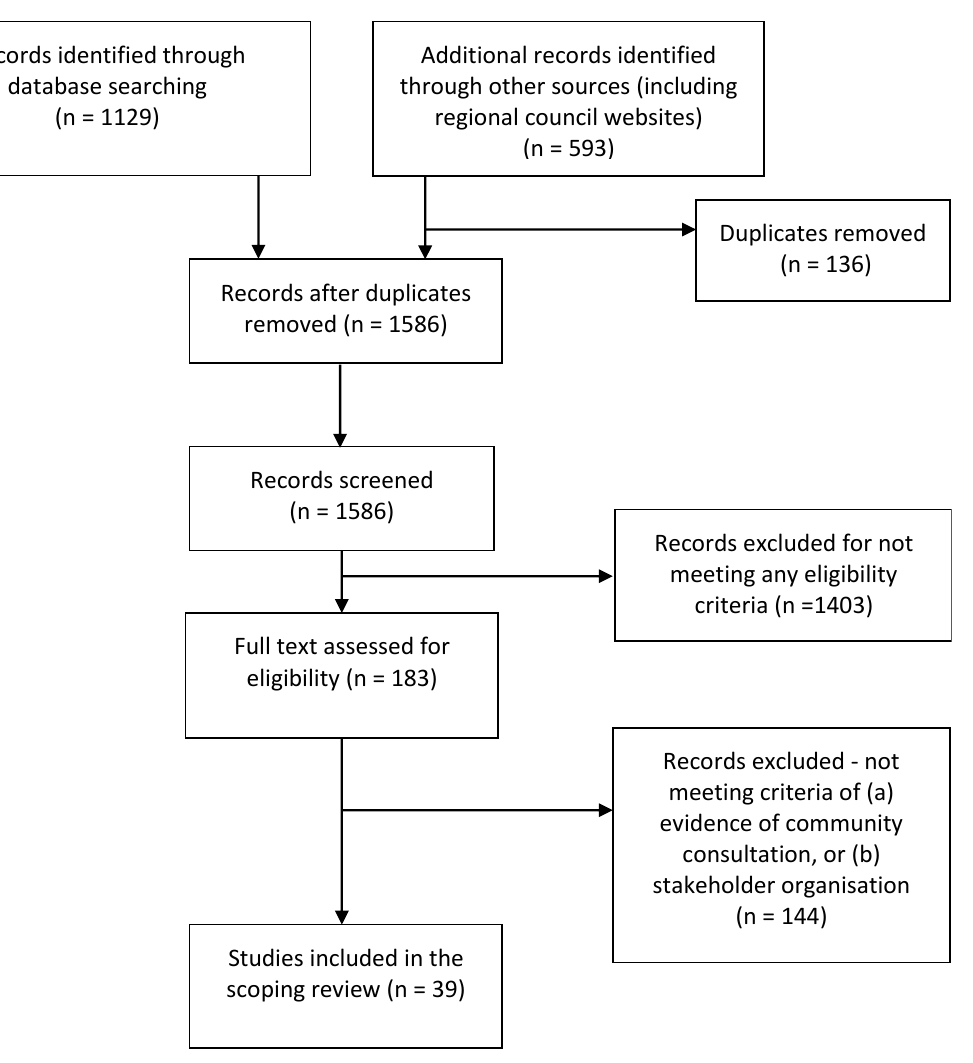
Figure 1. Process of identifying and selecting primary documents. Table 2. Descriptive characteristics of unique indicator statements related to socio-political and built environments according to type of planning document.